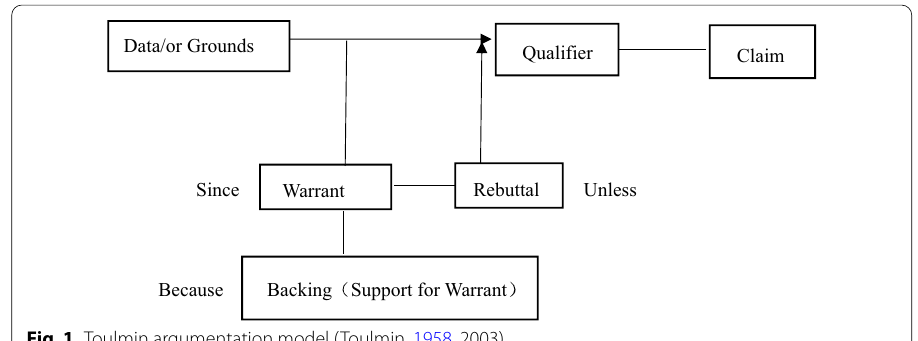
Fig. 1 Toulmin argumentation model (Toulmin, 1958, 2003)